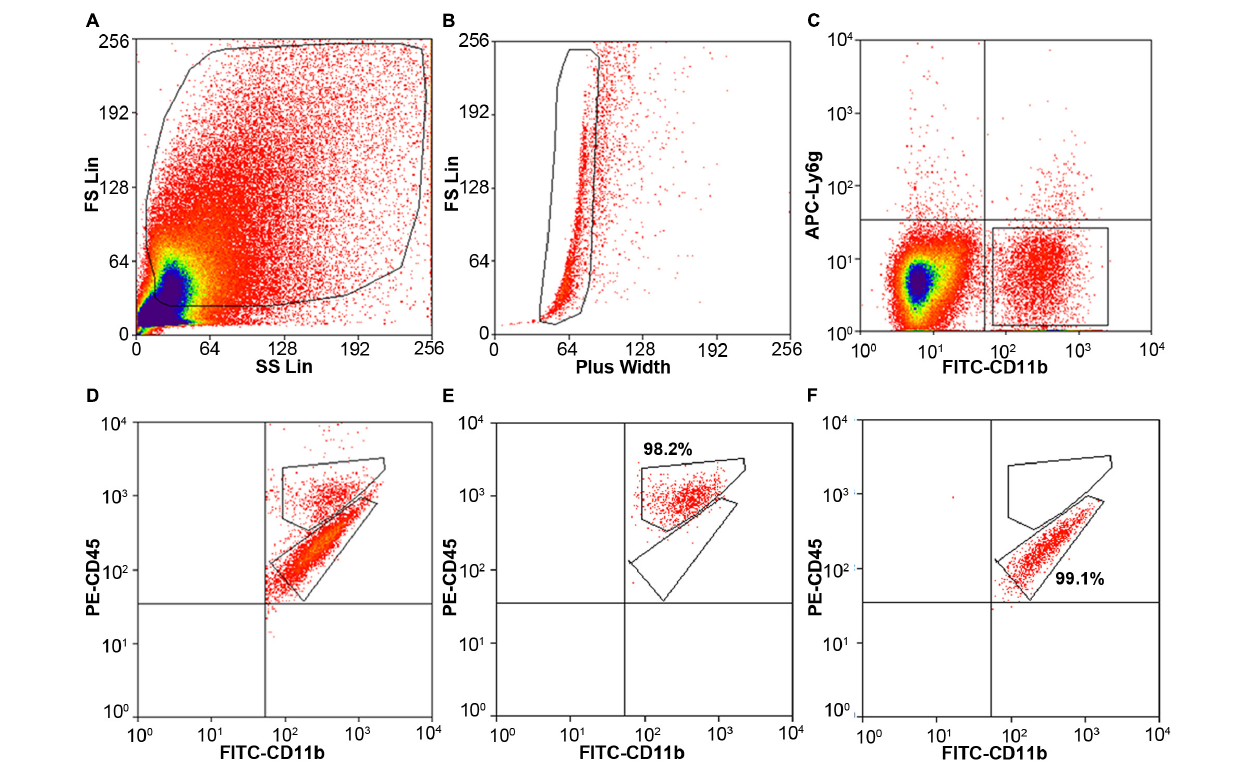
FIGURE 3 | Cell gating by flow cytometry. Eight- to ten-week-old male C57BL/6 mice underwent collagenase injection. Mice were sacrificed on day 1 post-ICH. Mouse brain was perfused with phosphate-buffered saline and dissociated into single cells. Cells were stained with APC-Ly6g, FITC-CD11b, PE-CD45, and propidium iodide (PI). (A) Representative gating of all cells. (B) Representative gating of singlets. (C) Representative gating of Ly6g − CD11b + PI − cells. (D) Representative gating of CD11b + CD45 high and CD11b + CD45 Int after gating from (C) . (E,F) the post-sort purity of monocytes/macrophages (E) and microglia (F)